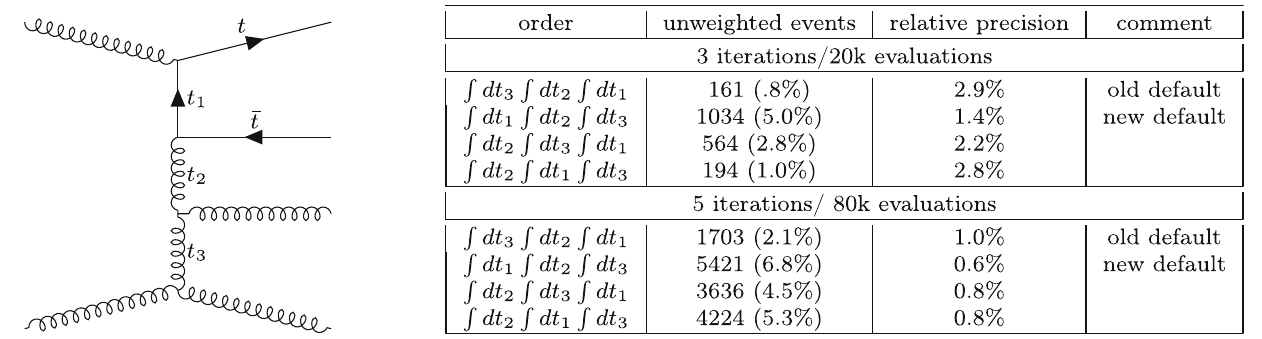
Fig. 4 Comparison of various orderings of the three variables of inte- gration corresponding to the invariant of time-like particles for the channel associated to the Feynman diagram represented on the left.